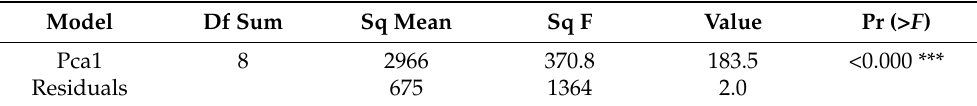
Table 6. ANOVA best teams.